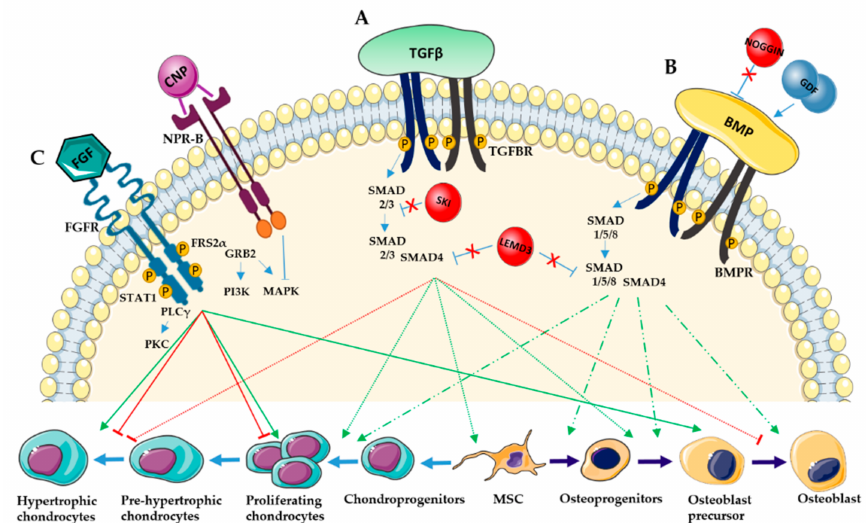
Figure 3. TGF β , BMP and FGF signaling pathways in chondrocyte and osteoblast differentiation. ( A ) TGF- β ligands bind to TGFBR type 1 and 2 causing the phosphorylation of the receptors and of SMAD 2 and 3 proteins which interact with SMAD4. This complex accumulates in the nucleus and induces chondrogenesis and osteoblastogenesis but inhibits the last step of chondrocyte and osteoblast maturation. SMAD activity can be blocked by intracellular inhibitors like SKI and LEMD3. ( B ) BMP ligands bind to BMPR type 1 and 2 causing the phosphorylation of the receptors and of SMAD 1, 5 and 8 proteins which interact with SMAD4. This complex accumulates in the nu- cleus and induces chondrocyte proliferation and all the steps of osteoblast differentiation. GDF ligands and the NOGGIN antagonist also bind BMPR. ( C ) FGF ligands bind FGFR causing receptor transphosphorylation, the phosphorylation of the adaptor protein FRS2 α and the activation of STAT1, PLC γ and GRB2. GRB2 in turn activates PI3K and MAPK proteins. Through these pathways, FGF promotes chondrocyte proliferation and differentiation in the first step of the development and it promotes osteoblast proliferation and differentiation. In contrast, in the later stages of development, it inhibits chondrocyte proliferation and differentiation. MAPK signaling, downstream of FGFR, can be negatively regulated by the CNP-NPR